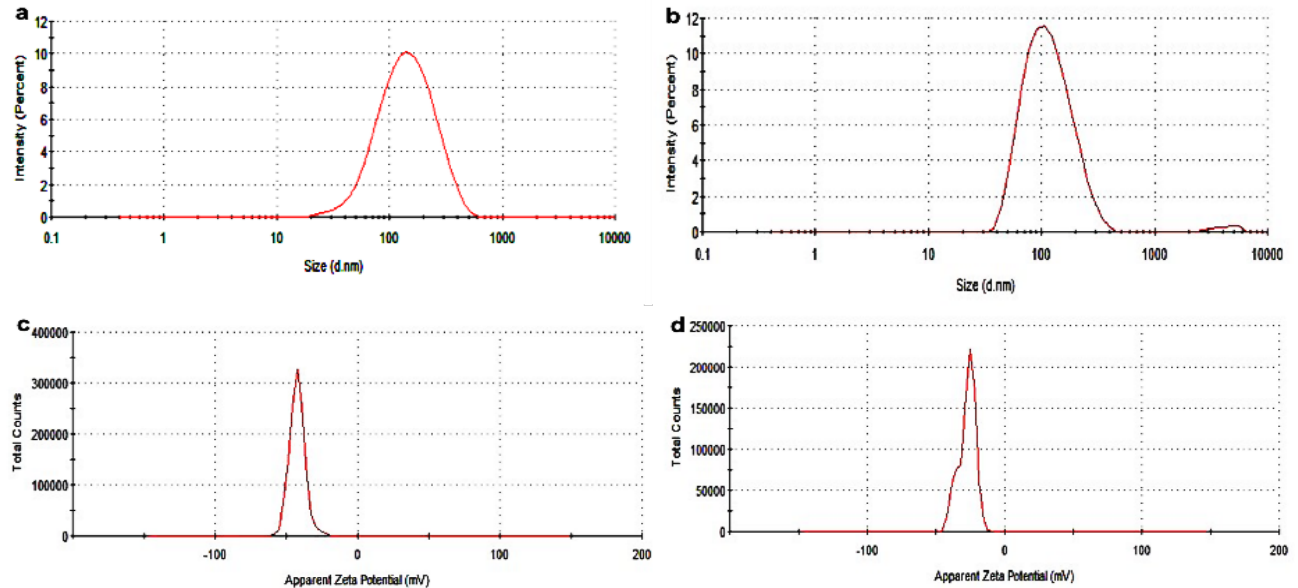
Figure 1. The generated particle size intensity profiles for ( a ) CLF and ( b ) CLPF. The particle zeta potential measurement profiles for ( c ) CLF ( d ) CLPF by dynamic light scattering. The samples were suspended in distilled water before measurement.